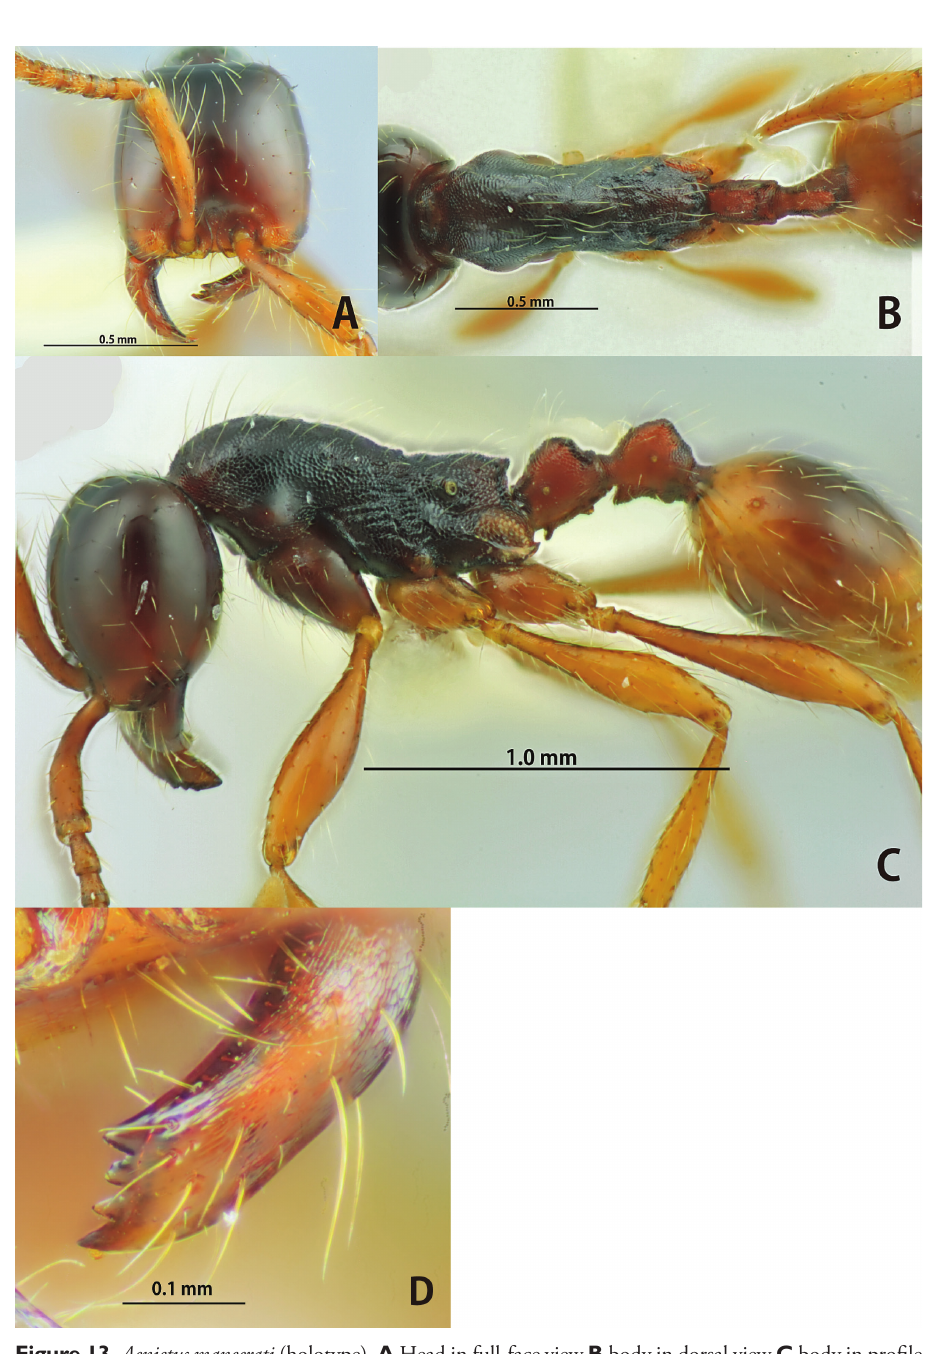
Figure 13. Aenictus maneerati (holotype). A Head in full-face view B body in dorsal view C body in profile D